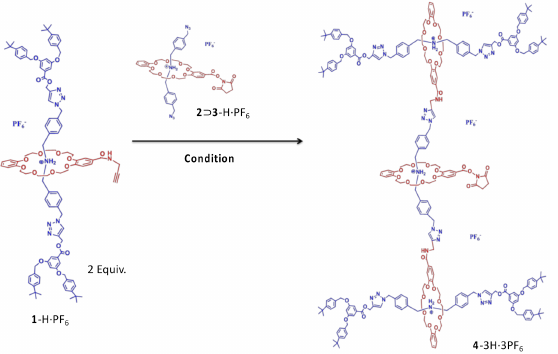
Figure 1. With G1 rotaxane dendron-acetylene 1 -H · PF 6 , double CuAAC reactions with pseudoro- taxane [ 2 ⊃ (cid:84) 3 -H · PF 6 ] yielded G2 rotaxane dendron-OSu 4 -3H · 3PF 6 . Condition: Cu(MeCN) 4 PF 6 (2 equiv.), DIPEA (2 equiv.), AcOH (4 equiv.) and CH 2 Cl 2 . R.t., 10 days,